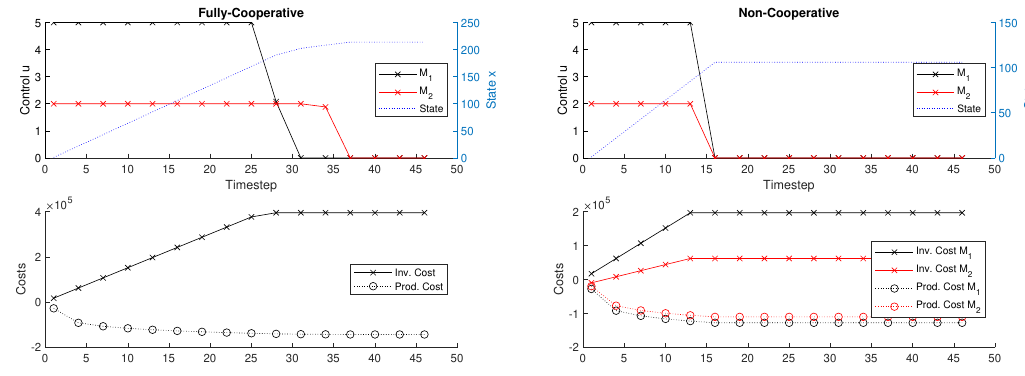
Figure 5. Supplier development schema for M 1 and M 2 in the cooperative and non-cooperative settings.